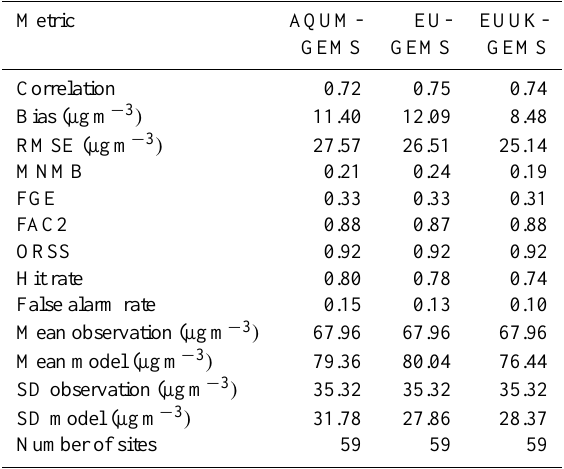
Table 5. Model performance metrics for ozone for the three model configurations AQUM-GEMS, EU-GEMS, EUUK-GEMS for the period 2 June to 29 July 2006.